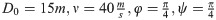
Agent trajectories (bird’s eye view) for different strategies in the three-dimensional case with and without drag.Initial conditions are set to D0=15m,ν=40ms,φ=π4,ψ=π4. Top row: with drag. Bottom row: without drag.